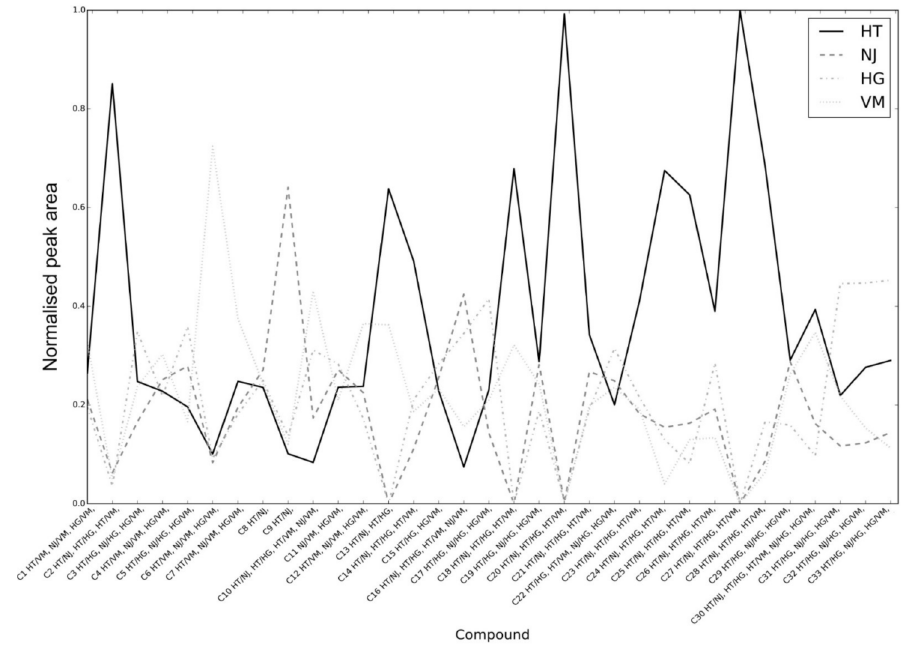
Figure 3. Plot of the mean of the peak area of each variety along the different compounds (with the magnitude normalized by the sum of all varieties) vs. the results of the significant pairwise tests for each compound. Abbreviations: HT, HT-801; HG, hybrid green F1; NJ, NJ-953; VM, “verde morado”.